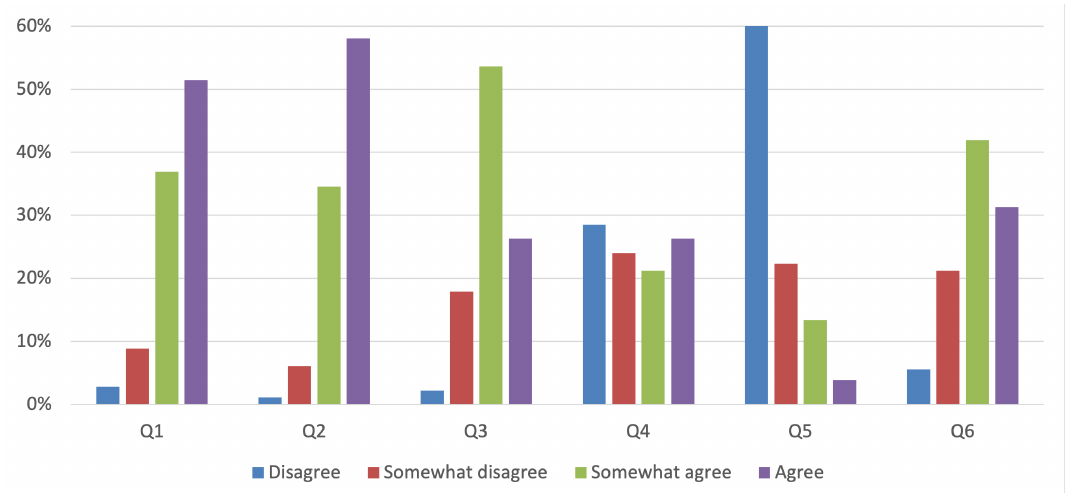
Figure 1. Define the level of agreement with the following topics regarding Open Research Data (Part 2, Q1 to Q6, All